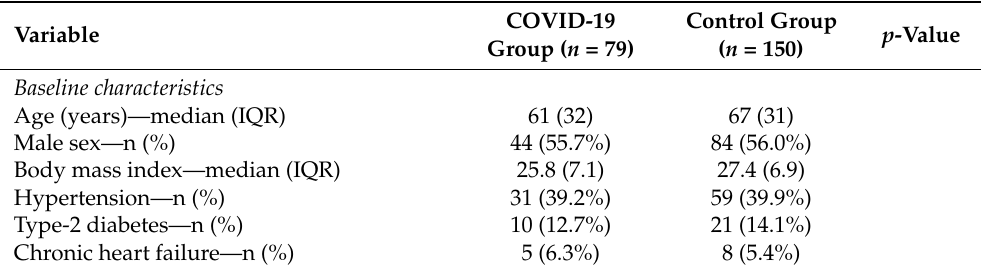
Table 1. Characteristics of pulmonary thromboembolism associated with COVID-19 vs. pulmonary thromboembolism without